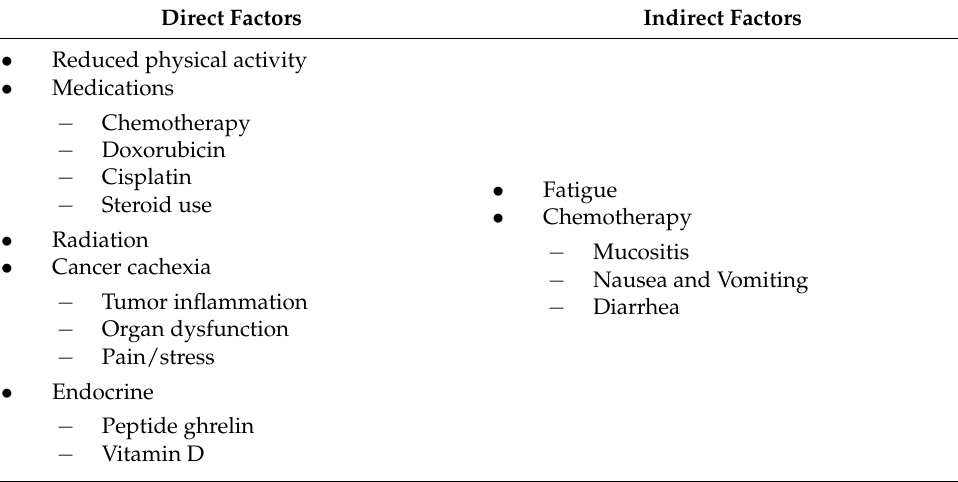
Table 1. Factors that may contribute to sarcopenia in children with solid organ tumors.